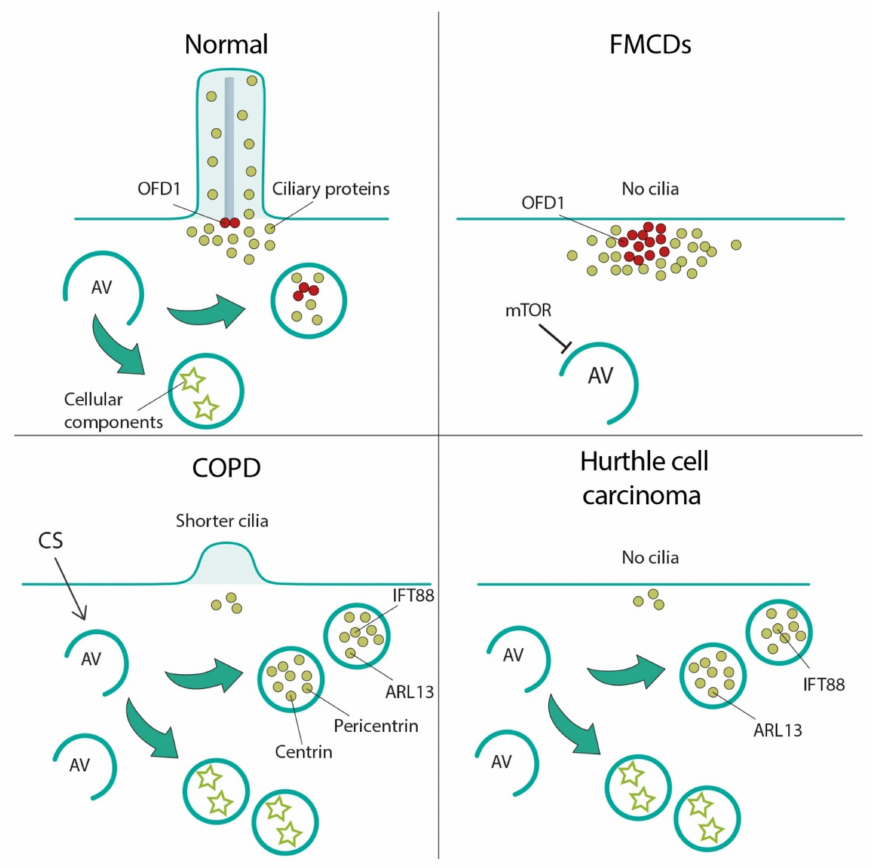
Figure 3. Cilia-autophagy crosstalk in diseases. Schematic representation of diseases characterized by cilia abnormalities because of autophagic defects. Focal cortical dyslamination (FMCDs), top right; in FMCDs neurons autophagy is inhibited by mTOR overactivation, which results in loss of autophagic degradation of the satellites pool of the OFD1 protein, a ciliogenesis inhibitor, with consequent defective formation of cilia. Chronic obstructive pulmonary disease (COPD), bottom left; autophagy increases in COPD cells under cigarette smoke (CS) exposure and causes cilia shortening by increased autophagic degradation of ciliogenic proteins. Hurthle cell carcinoma, bottom right; high basal level of autophagic activity suppresses ciliogenesis by persistent sequestration of ciliogenic proteins into autophagosomes. AV: autophagic vacuoles; ciliary proteins: green circles; OFD1: red circles; autophagy proteins: purple rectangles; cellular components: